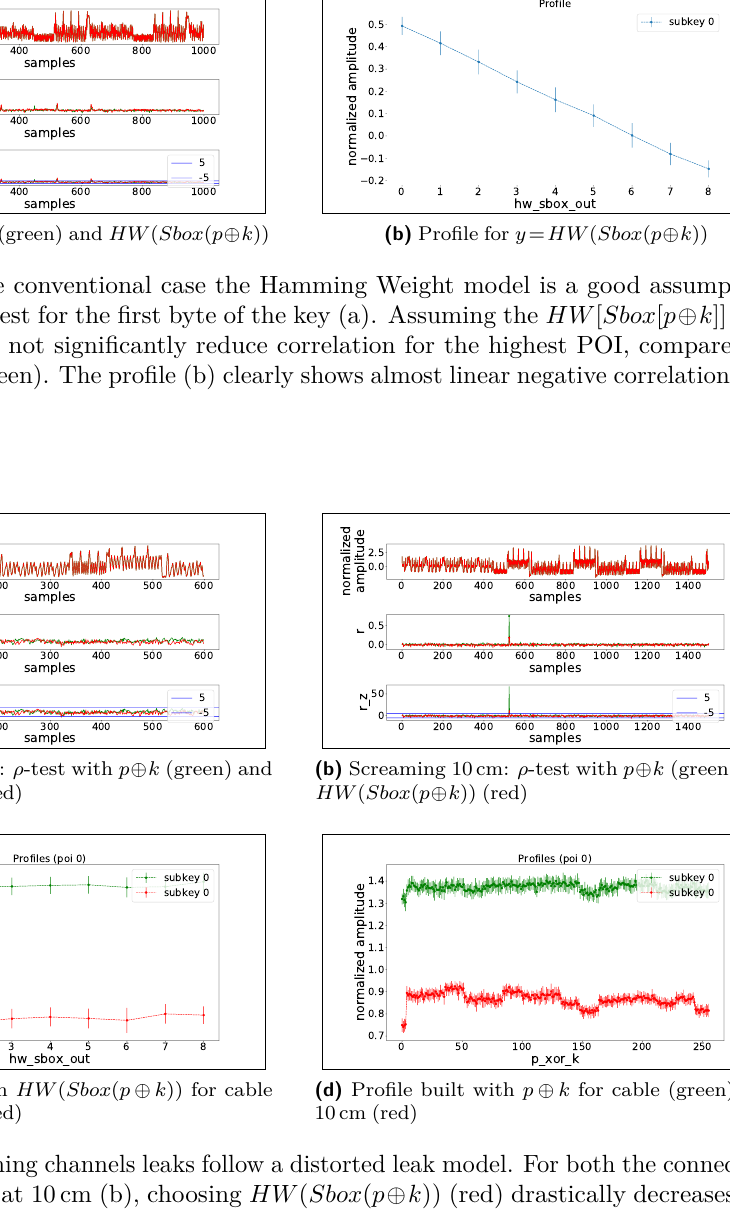
Channel Frequency Does Not Impact Distortion. For each set we run the ρ -test, and we correlate each profile with the one at 2.400 GHz to observe if there is any distortion. Results in Table 3 show that the amount of correlation and the shape of profiles is mostly constant. We conclude that the distortion of screaming channels does not have a strong dependency on the frequency of the